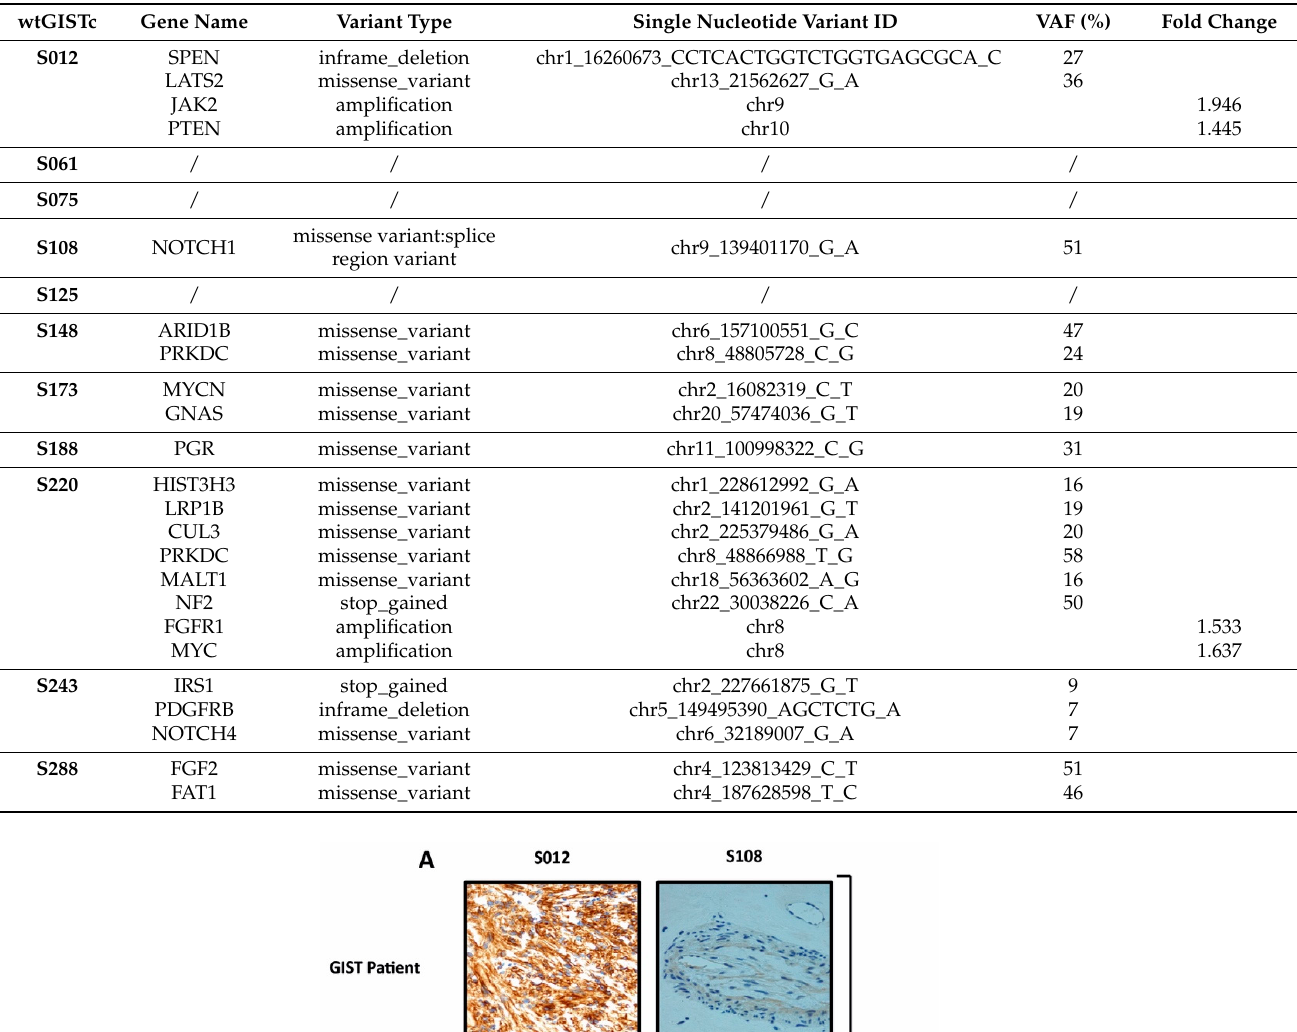
Table 1. Mutational profile of wtGISTc as assessed by targeted sequencing. VAF: Variant Allele Frequency.